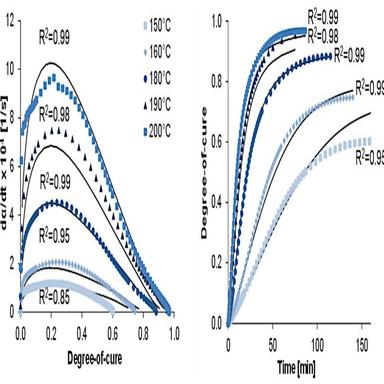
Cure rate vs. degree-of-cure (left) and degree-of-cure vs. time (right) with model predictions (solid line) of epoxy RS-36-1. (For interpretation of the references to colour in this figure legend, the reader is referred to the web version of this article.)